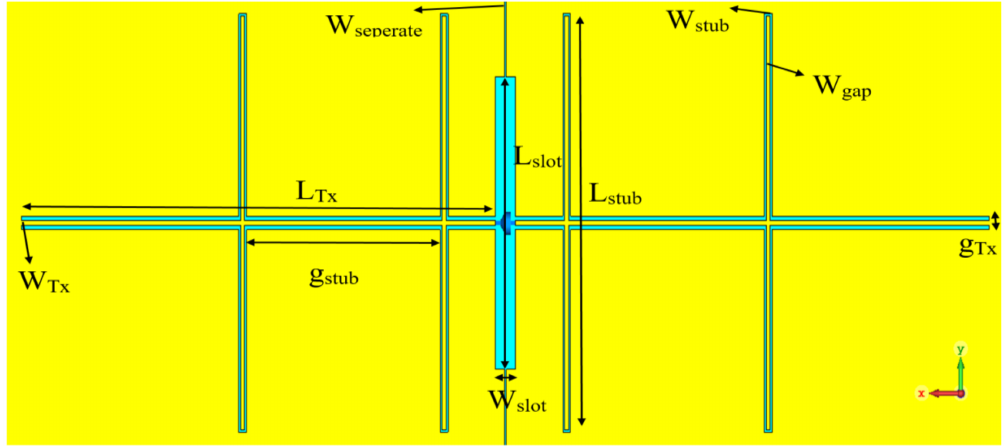
Figure 8. Top view of feeding slot and CPS.